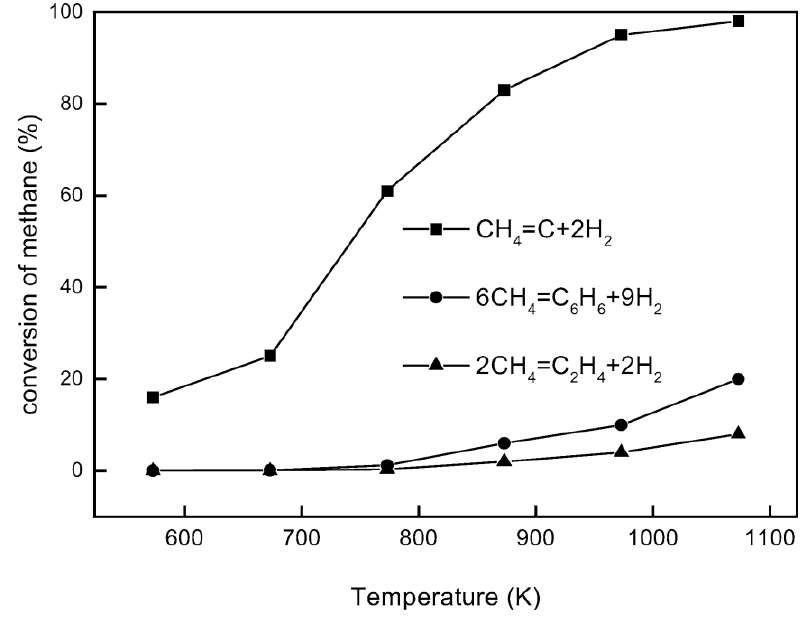
Figure 1. Equilibrium conversion of methane for direct conversion methods under non-oxidative conditions [6]. Copyright 2003 Elsevier.